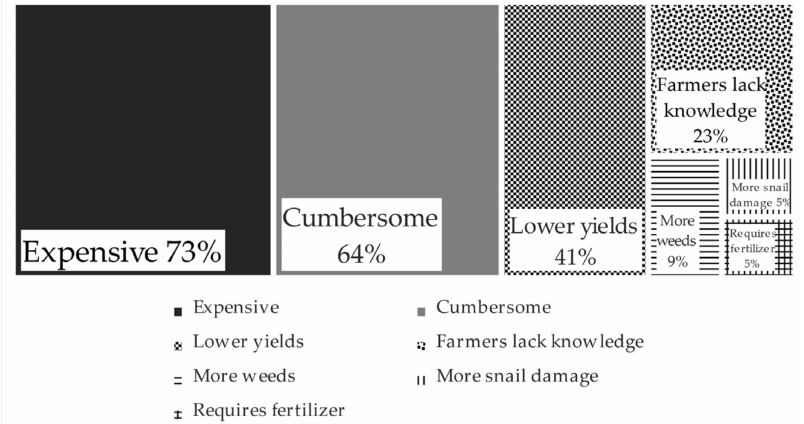
Figure 6. Farmer’s ranking of the perceptions on why line transplanting of rice is not practiced by many farmers in the Doho rice